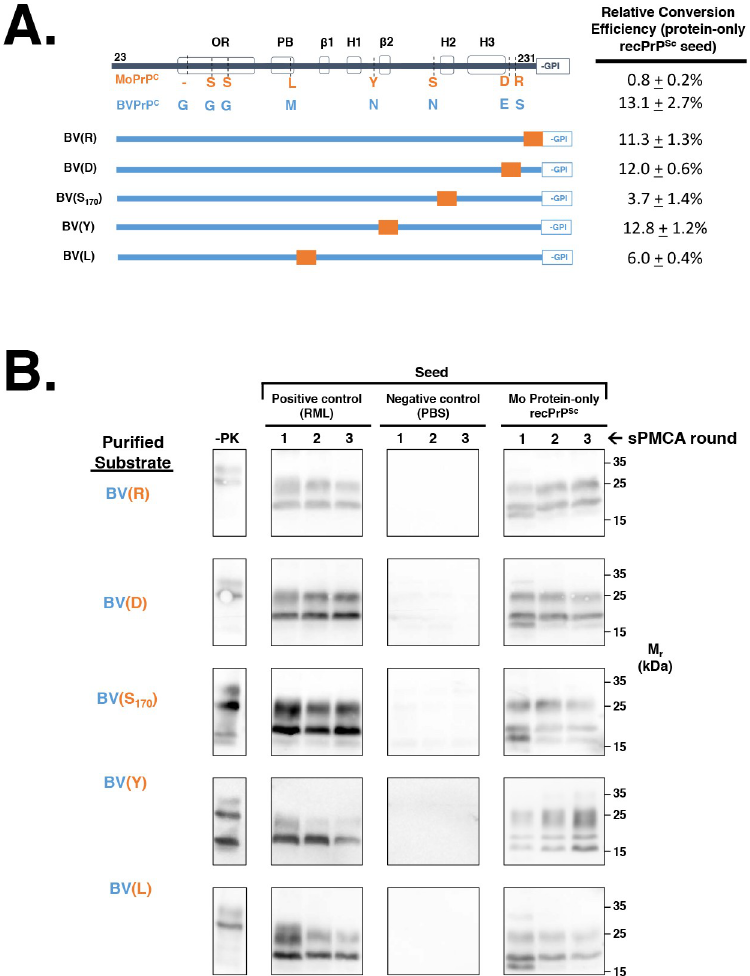
Fig 4. Determining the effect of single Mo amino acid mutations on the propagation of Mo protein-only recPrP Sc . (A) Table summarizing the effect of single Mo amino acid substitutions on the ability of BV/Mo PrP C chimeras to propagate Mo protein-only recPrP Sc . All constructs are based on the BV PrP C backbone. (B) Western blots of experiments summarized in (A), showing three-round reconstituted sPMCA reactions using partially purified PrP C substrates supplemented with PrP 0/0 BH and seeded with various seeds, as indicated. -PK = samples not subjected to proteinase K digestion; all other samples were proteolyzed.